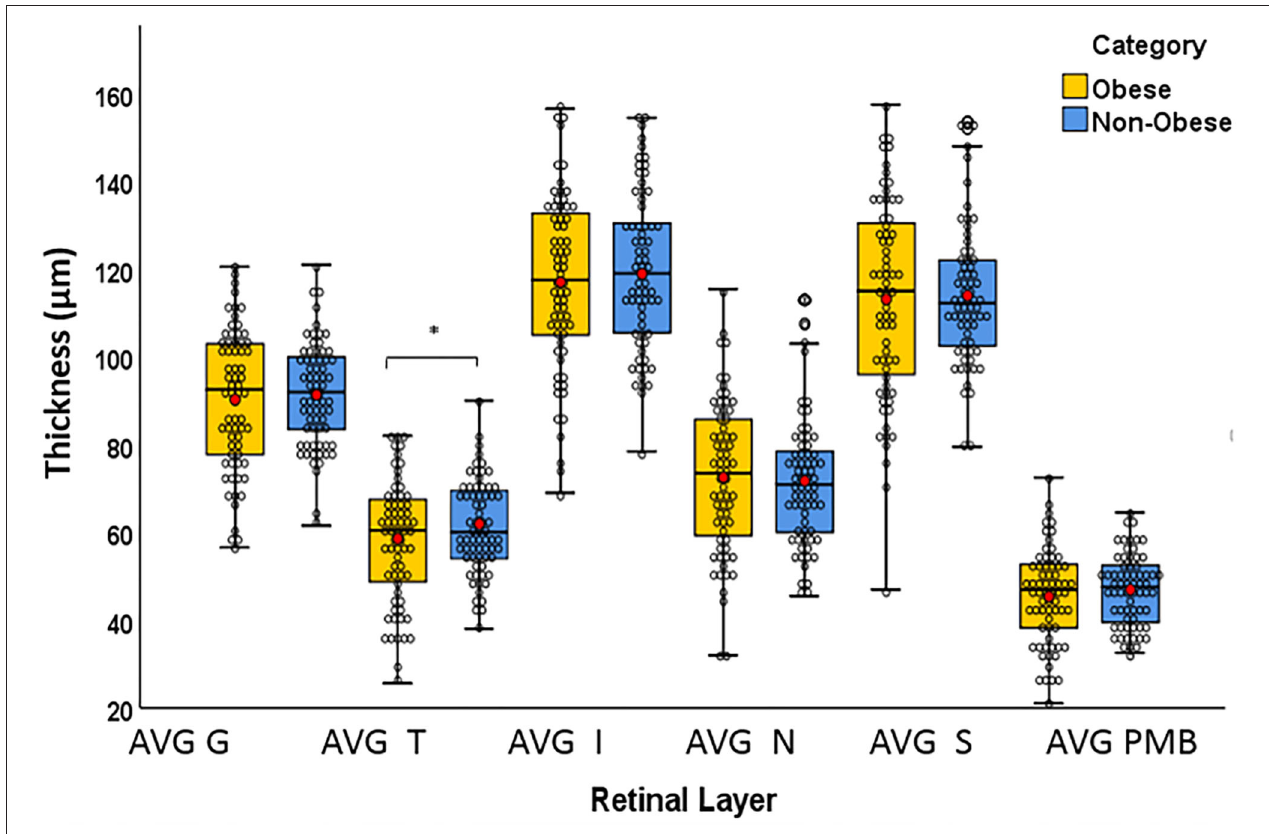
FIGURE 2 | Box plots overlaid with dot plots showing retinal layer thickness by BMI category (*statistically significant). Red dots represent means. µ m: micrometer. G, global; T, temporal; I, inferior; S, superior; N, nasal; PMB, papillomacular bundle. *Statistically significant.